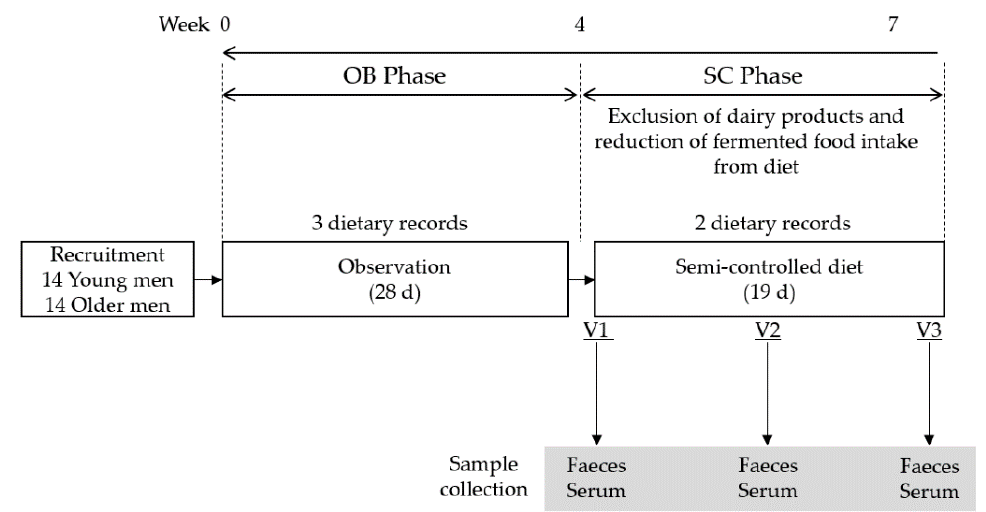
Figure 1. Overview of study design. A total of 14 healthy young adult men (YA) and 14 older adult men (OA) participated in a 28 ‐ day observation phase (OB phase) with 3 dietary records conducted at intervals of 9 ± 4 days. The semi ‐ controlled diet phase (SC phase) excluded dairy product intake and reduced fermented food intake for 19 days in a free ‐ living condition. During the SC phase, fasting serum samples were collected on three visits (V1 on day 1, V2 on day 8–14, V3 on the day 19 of intervention). Faecal samples were collected either a day before each visit or on the morning of the visit.